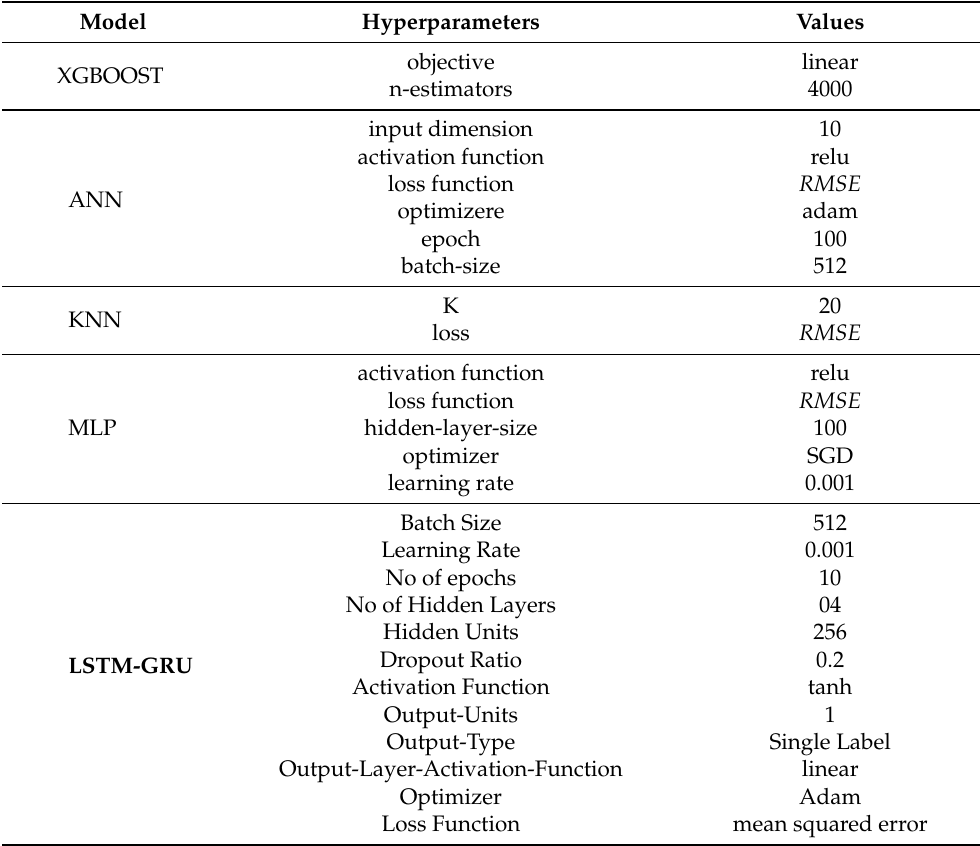
Table 2. Hyperparameters configuration for XGBoost, ANN, KNN, MLP, and Hybrid